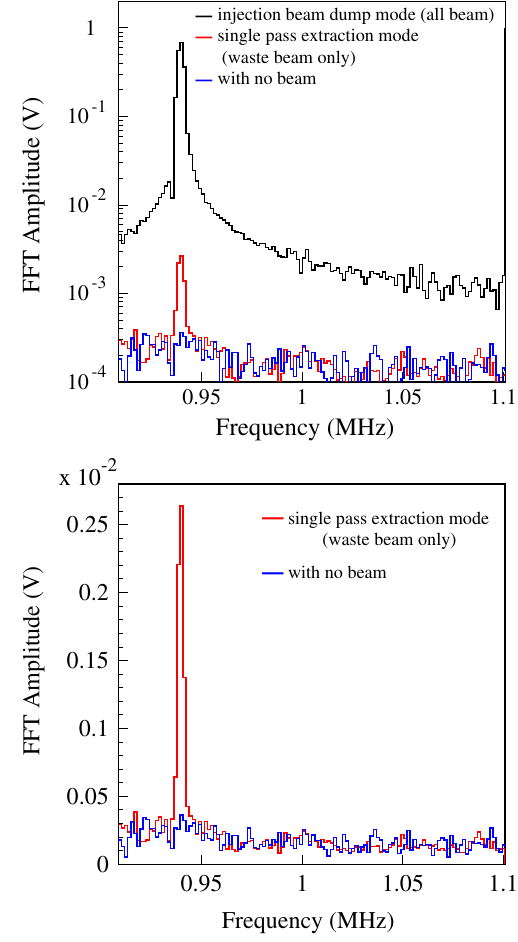
FIG. 7. Expanded view near the fundamental frequency region of the FFT spectra shown in Fig. 6. Data for all three cases are in the upper graph, whereas data for the later two cases in the lower graph are shown with a linear vertical scale. No indication of any signal in the expected frequency region with no beam as compared to a clear signal with beam can easily be seen. The signal with beam was about 1 order of magnitude higher as compared to that with no beam at the fundamental frequency of 0.940 MHz.